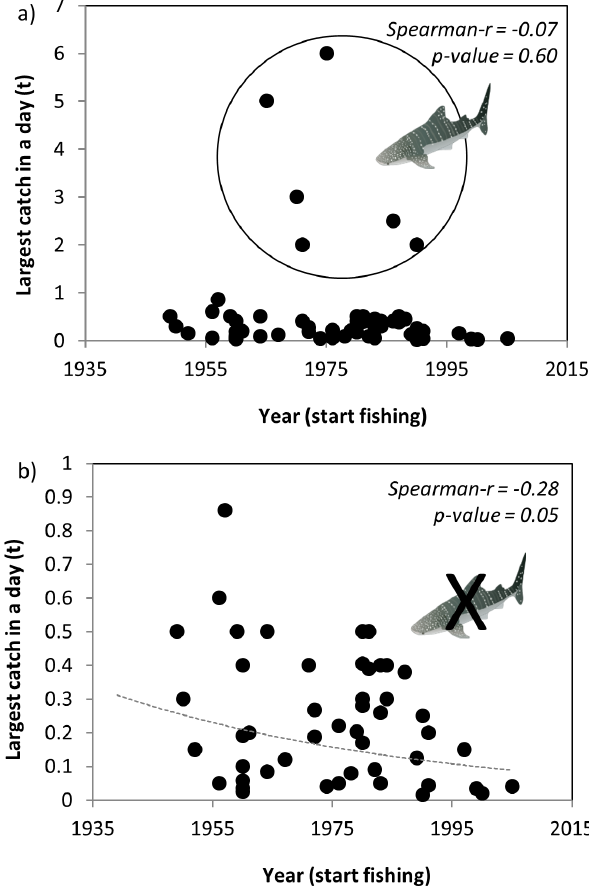
Figure 7. Assessment of the a) largest caught species in a day of fishing (t) and year of starting fishing (n=58), and b) largest caught species in a day of fishing (t) and year of starting fishing, excluding whale and basking sharks (n=56). (Species drawings: http://ian.umces.edu/symbols).